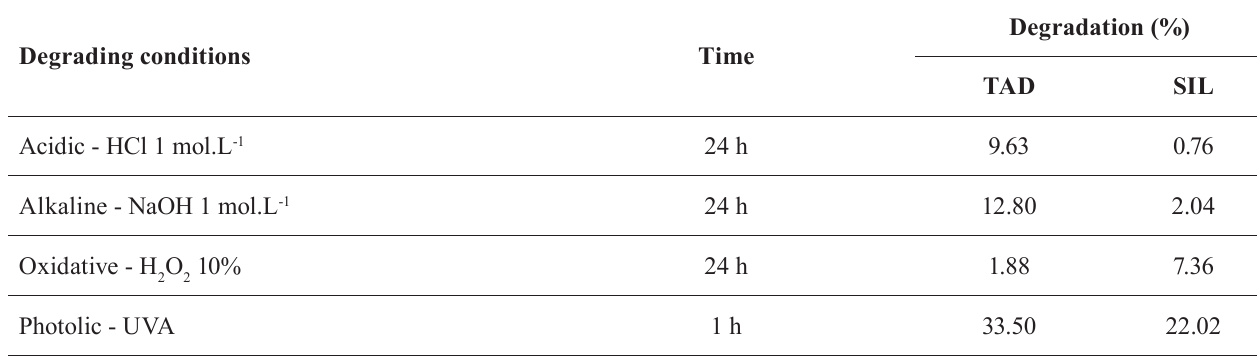
TABLE III - Forced degradation of associated TAD and SIL